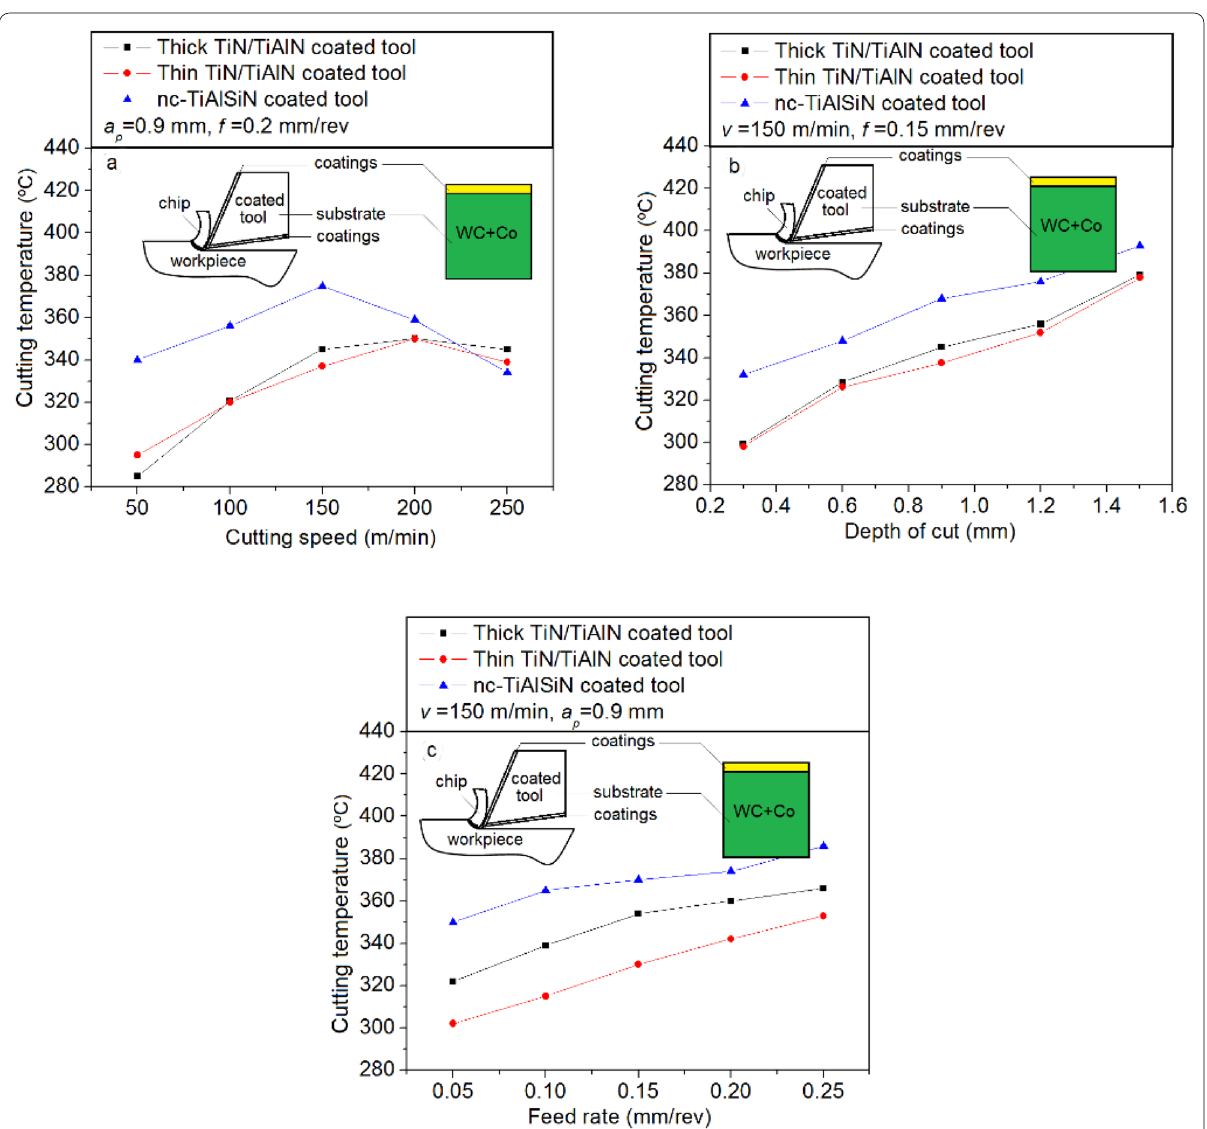
Figure 6 Cutting temperatures of the three coated tools under various cutting conditions in dry turning of MCI: a a p 150 m/min, f 0.15 mm/rev; and c v = =